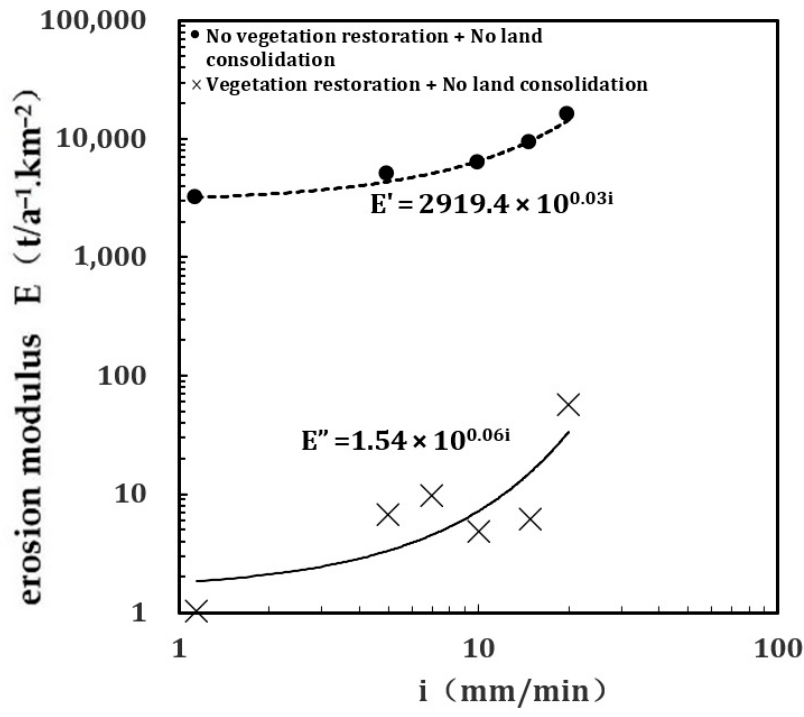
Figure 17. Changes in erosion modulus with rain intensity before and after control.